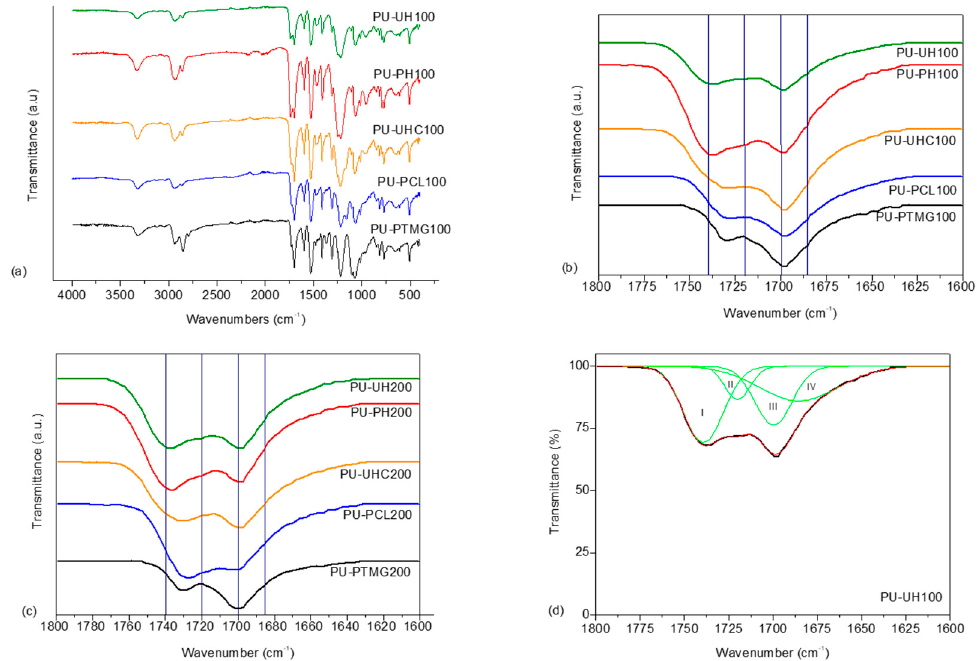
Figure 3. Fourier transform infrared-attenuated total reflection spectra showing transmittance spectra of ( a ) the different polyurethanes; ( b ) the carbonyl region for polyurethanes with macrodiol of 1000 g/mol; ( c ) the carbonyl region for polyurethanes with macrodiol of 2000 g/mol; and ( d ) fitting with four absorption peaks to the experimental carbonyl band of PU-UH100.